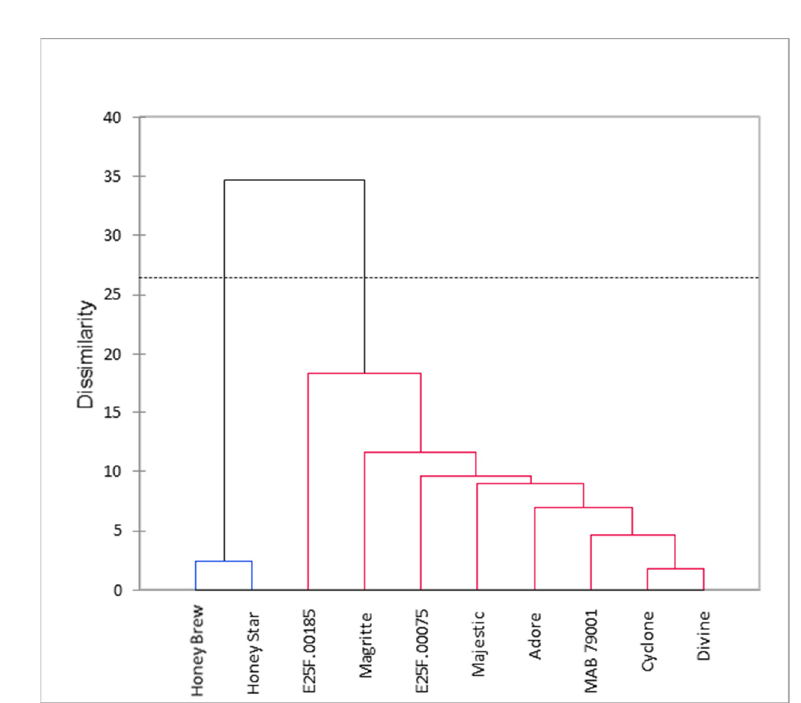
Figure 4. Dendrogram indicating the interrelatedness of the cultivars based on the measured fruit quality at harvest.